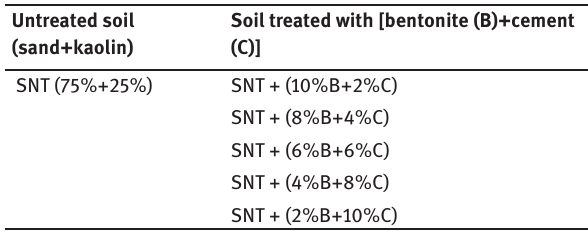
Table 3: Variations of the different mixing ratios of the components (bentonite–cement). Untreated